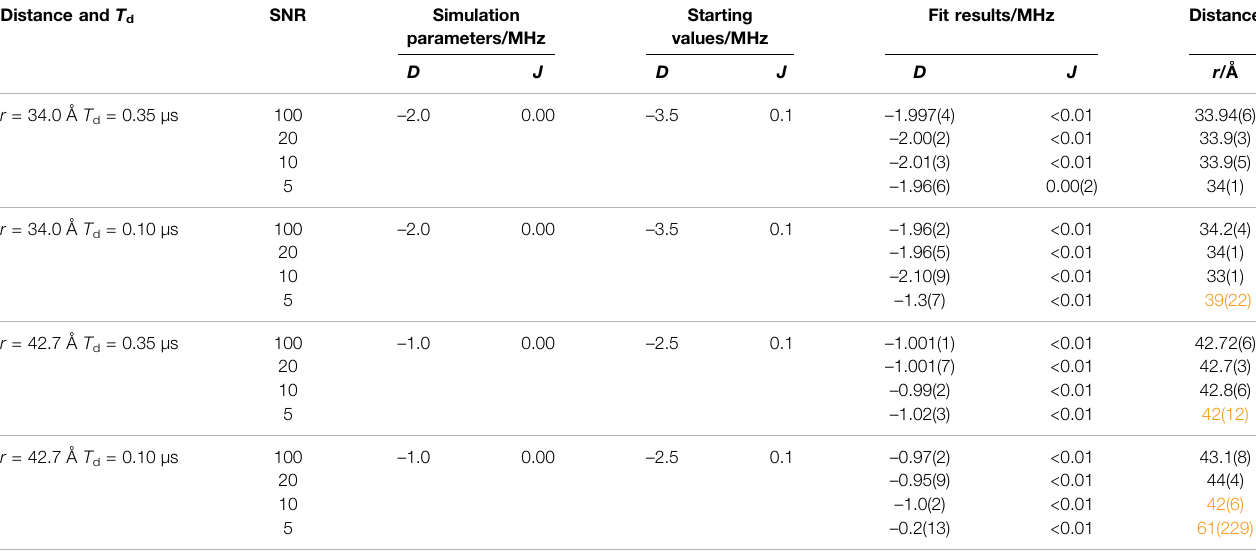
TABLE 2 | Comparisons of calculated OOP-ESEEM time traces using different D and J value combinations with results from numerical simulations using Eq. 5 . Starting values for least-squares fi ttings were T d = 0.25 µs and H = 1. D , J , T d , and H were allowed by the fi tting routine to be varied in the intervals – 20 MHz ≤ D ≤ 0, 0 ≤ J ≤ 10 MHz,0 ≤ T d ≤ 10 µs,and0 ≤ H < ∞ .Thedistance r wascalculatedusing Eq.3 .Obtaineddistanceswithincreasederrormargin( > 10%)orincorrectvaluesarehighlighted in